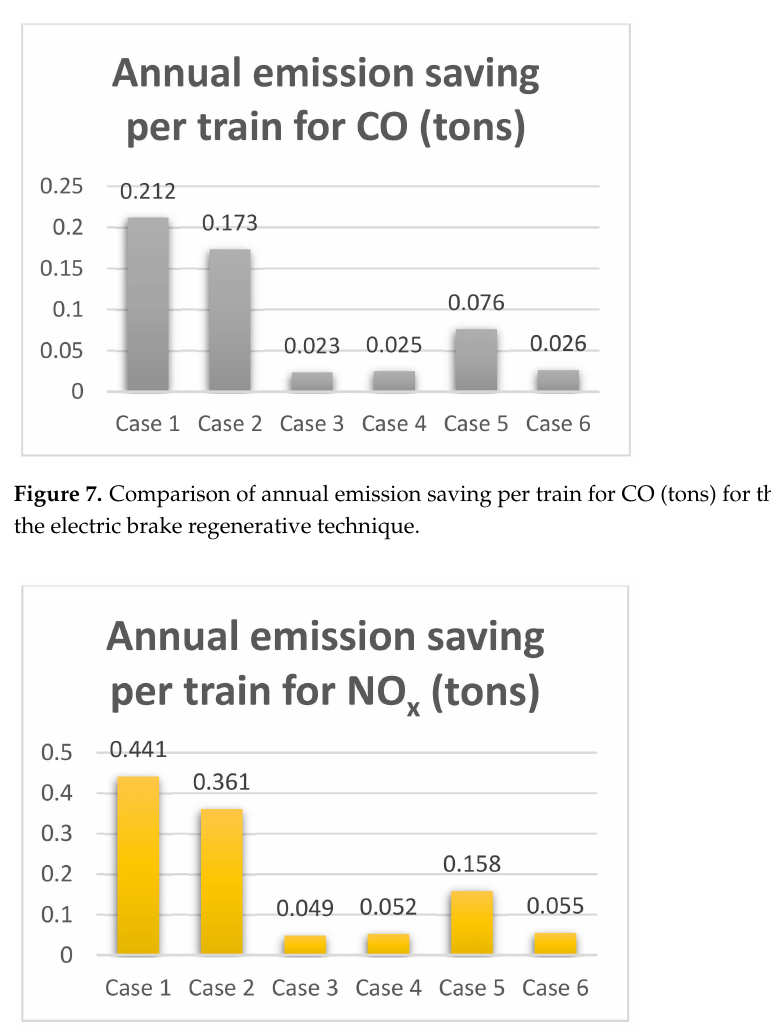
Figure 8. Comparison of annual emission saving per train for NO x (tons) for the six cases when using the electric brake regenerative technique.